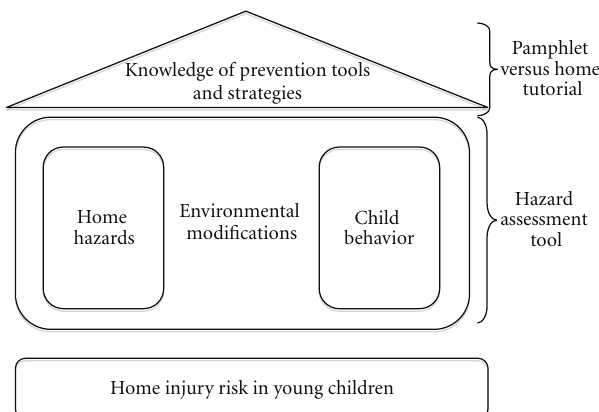
Figure 1: Schematic framework for home injury hazard assessment and